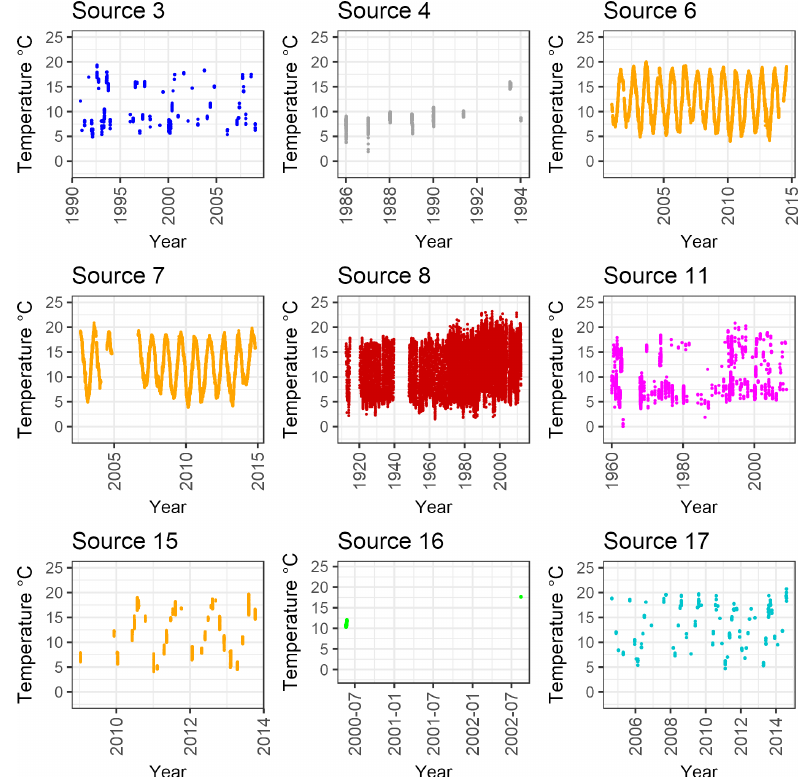
Figure 9. Near-surface (0–5m) data coverage and temperatures in the southern North Sea by source and time. Note the different timescales for each data source.